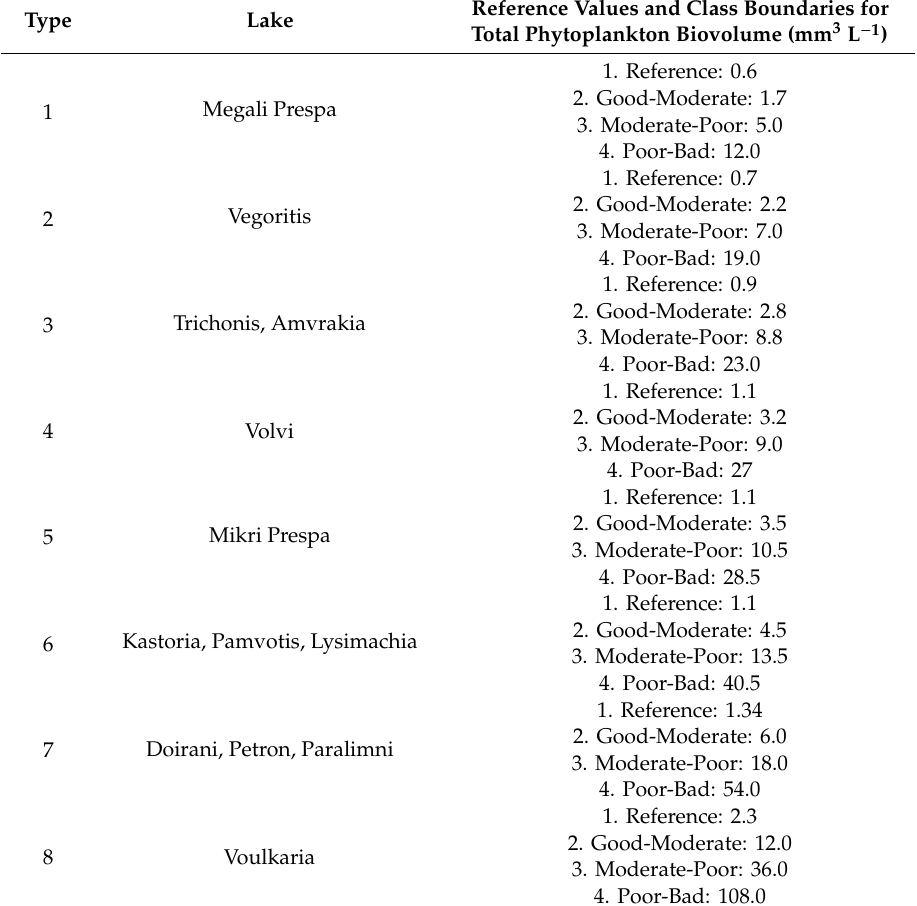
Table A2. Class boundaries for total phytoplankton biovolume for studied Greek